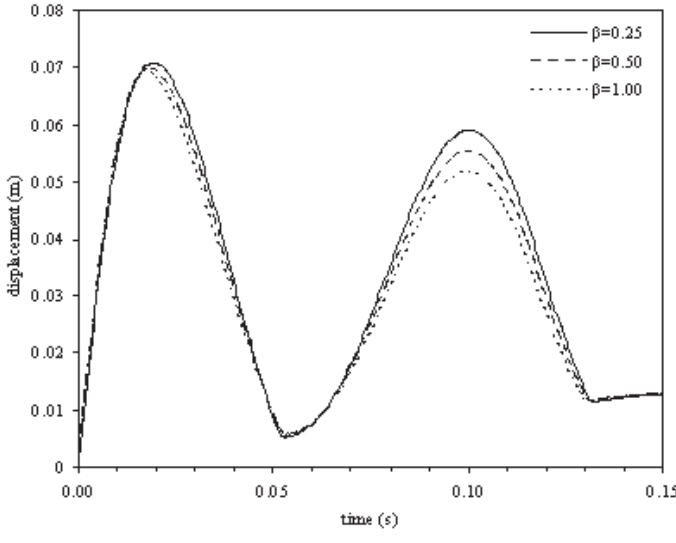
Fig. 12. Comparison of the displacement of m 1 using a 41 DOF CAFE mesh with, β = 0.25, β = 0.50, and β =